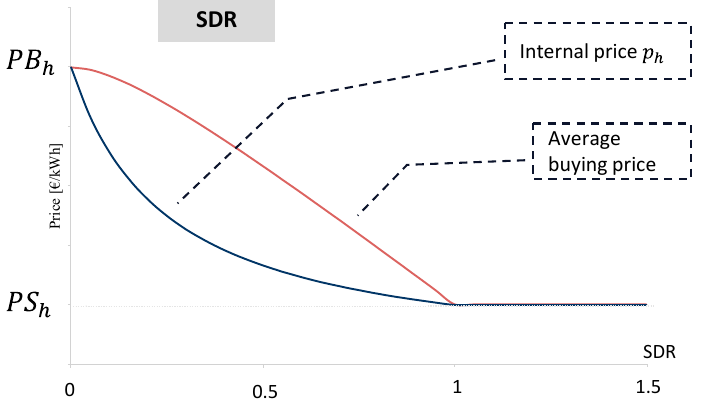
Figure 5. Relationship between PS h , PB h with the SDR pricing.